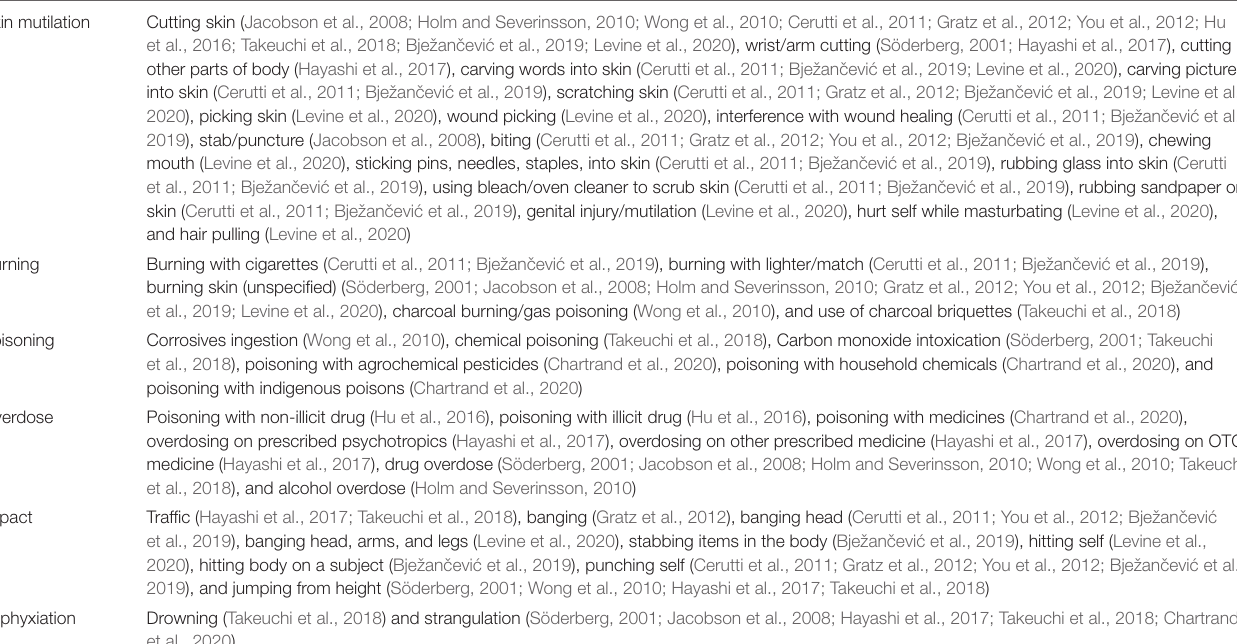
TABLE 5 | Self-harm methods for BPD which were indicated in the literature. Skin mutilation